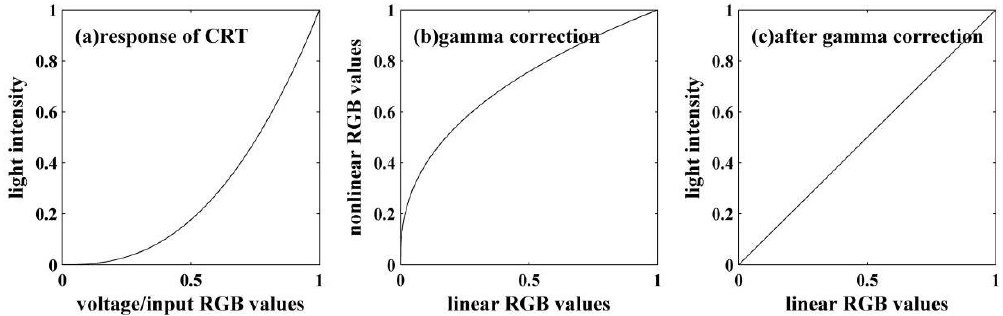
Figure 4. ( a ) Cathode ray tube (CRT) in the monitor has a power law response to the applied voltage or input RGB values. ( b ) Linear RGB values are transformed to nonlinear RGB values with gamma correction. ( c ) Nonlinear RGB values instead of linear RGB values are input into the CRT and the color displayed is consistent with the original linear RGB